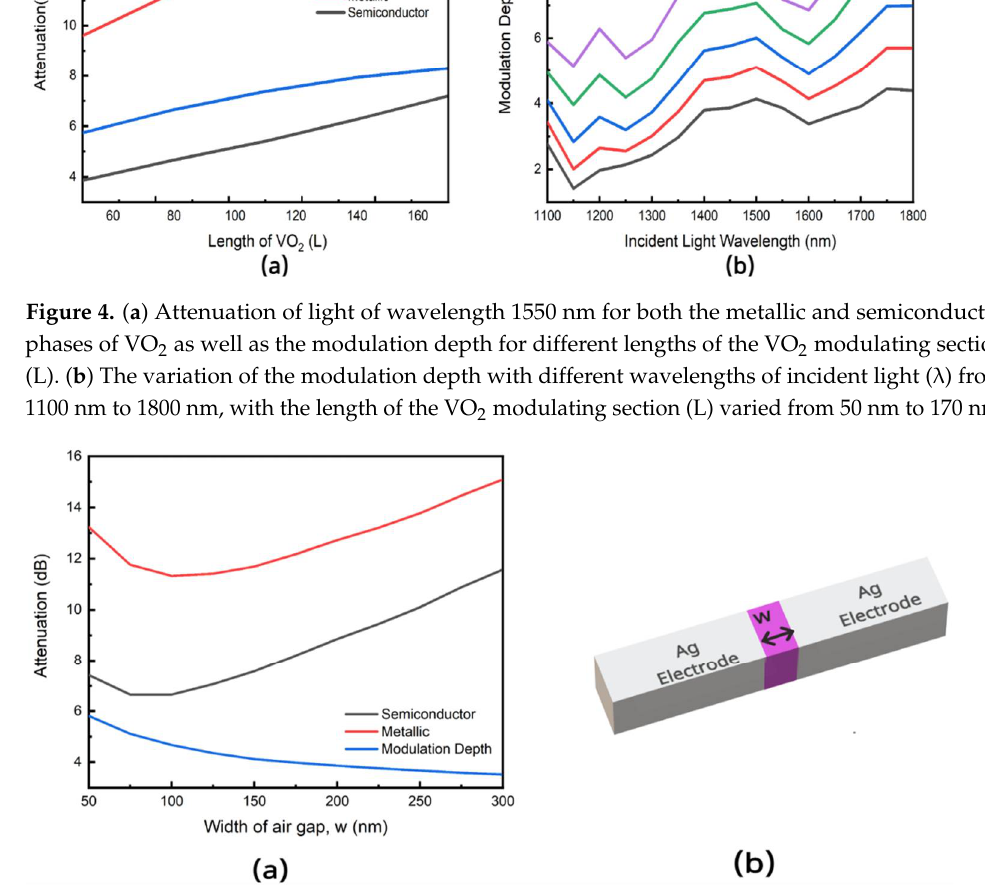
Figure 4. ( a ) Attenuation of light of wavelength 1550 nm for both the metallic and semiconductor phases of VO 2 as well as the modulation depth for different lengths of the VO 2 modulating section (L). ( b ) The variation of the modulation depth with different wavelengths of incident light (λ) from 1100 nm to 1800 nm, with the length of the VO 2 modulating section (L) varied from 50 nm to 170 nm.